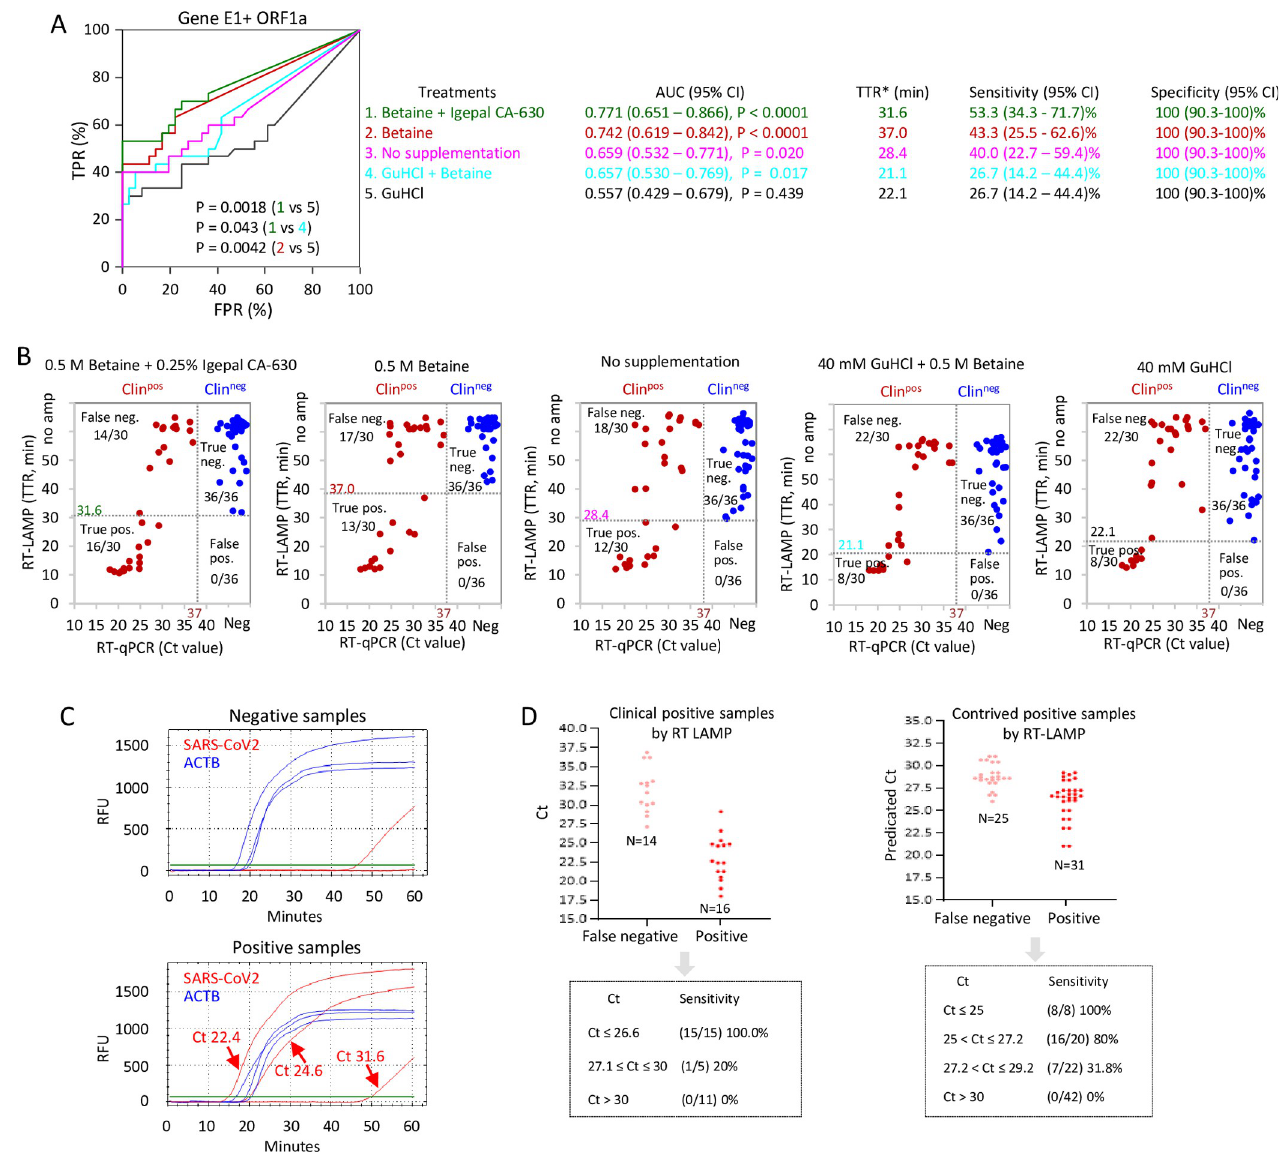
Fig 5. Direct RT-LAMP on raw clinical NP samples without RNA extraction. (A) ROC curves evaluating RT-LAMP performance on 30 positive and 36 negative clinical NP samples with the indicated supplements. 0.5M betaine + 0.25% Igepal CA-630 in green; 0.5M betaine in red; No supplements in pink; 40mM GuHCl + 0.5M betaine in light blue; 40mM GuHCl in black. 1 μ l of raw samples (without any sample processing) was applied to RT-LAMP reactions, and the reactions were carried out with multiplexing primers for Gene E1 and ORF1a. Significance values were calculated with MedCalc software for ROC curve analysis. TTR � indicates the cutoff providing optimal sensitivity and specificity. (B) Distribution of the RT-LAMP TTRs vs . BGI RT-PCR Ct values with the indicated supplements. Dotted lines indicate cutoffs. (C) Representative fluorescent readouts of RT-LAMP with 0.5M betaine and 0.25% Igepal CA-630. (D) Sensitivity of RT-LAMP at the indicated Ct ranges. Left panel, Clinical NP samples. Right panel, Contrived positives generated by diluting clinical NP positives with negative NP samples.